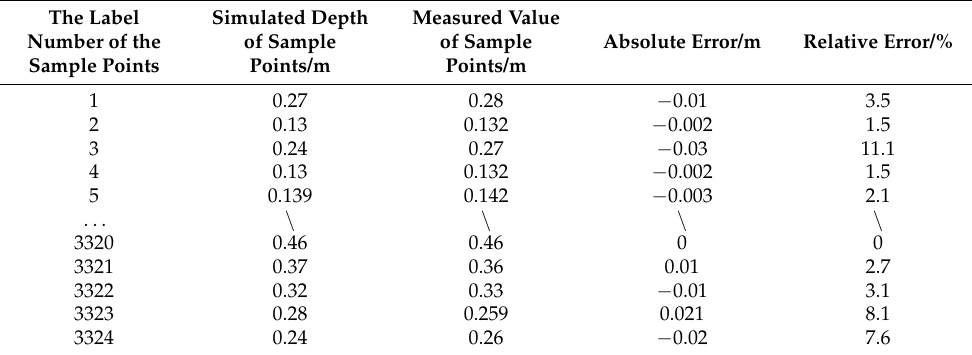
Table 2. Simulation results of the test set by the NB model (5 August 2016).